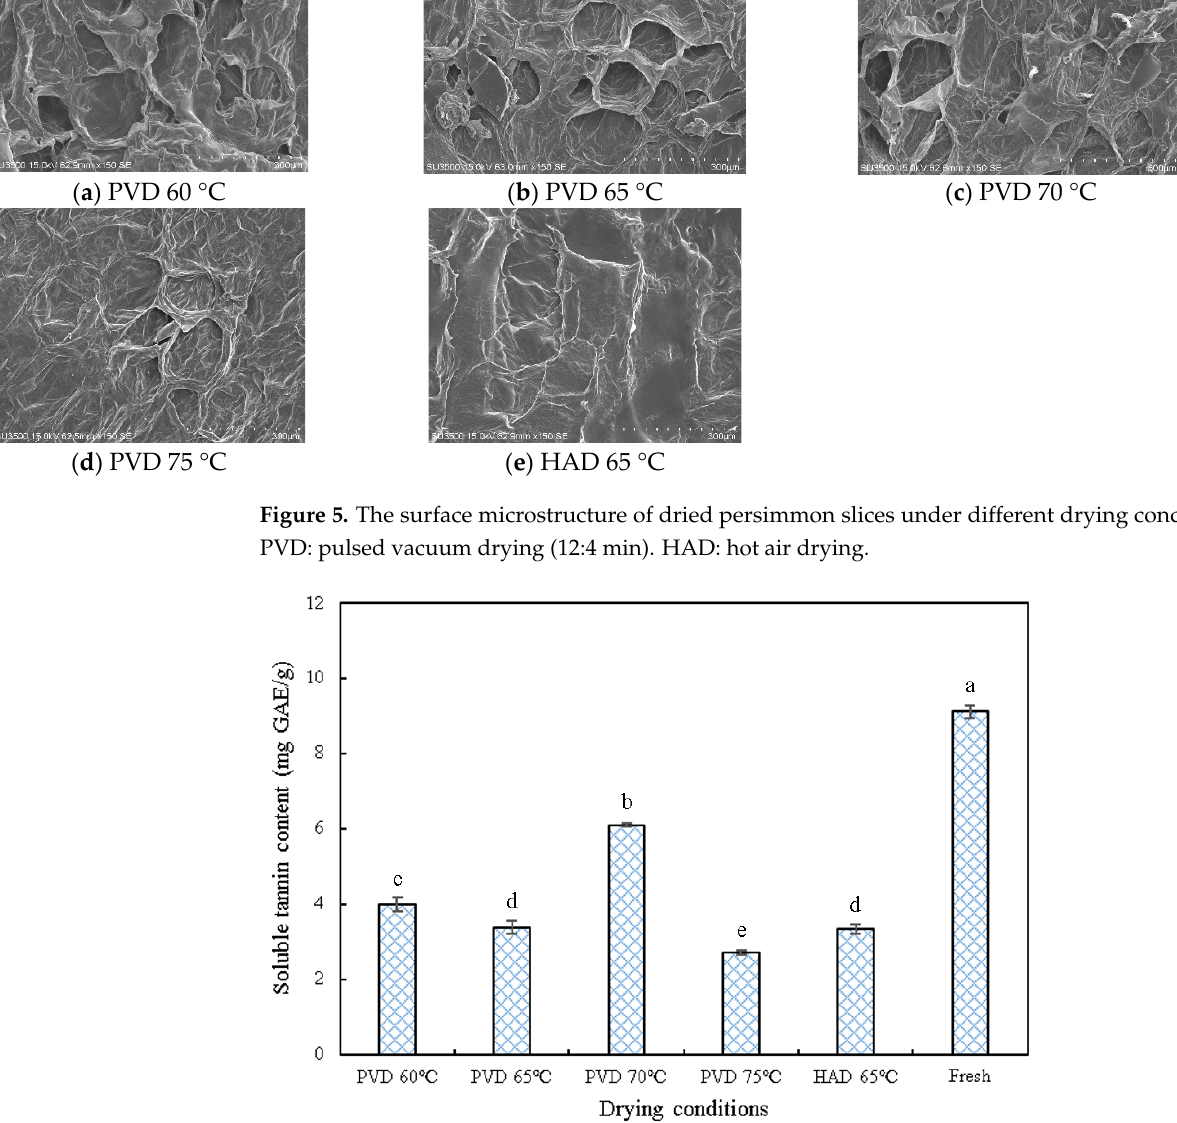
Figure 6. Effects of different drying treatments on soluble tannin content. PVD: pulsed vacuum drying (12:4 min). HAD: hot air drying. The different letters, a, b, c, d, and e, reveal significant differences ( p < 0.05) according to the Duncan test.